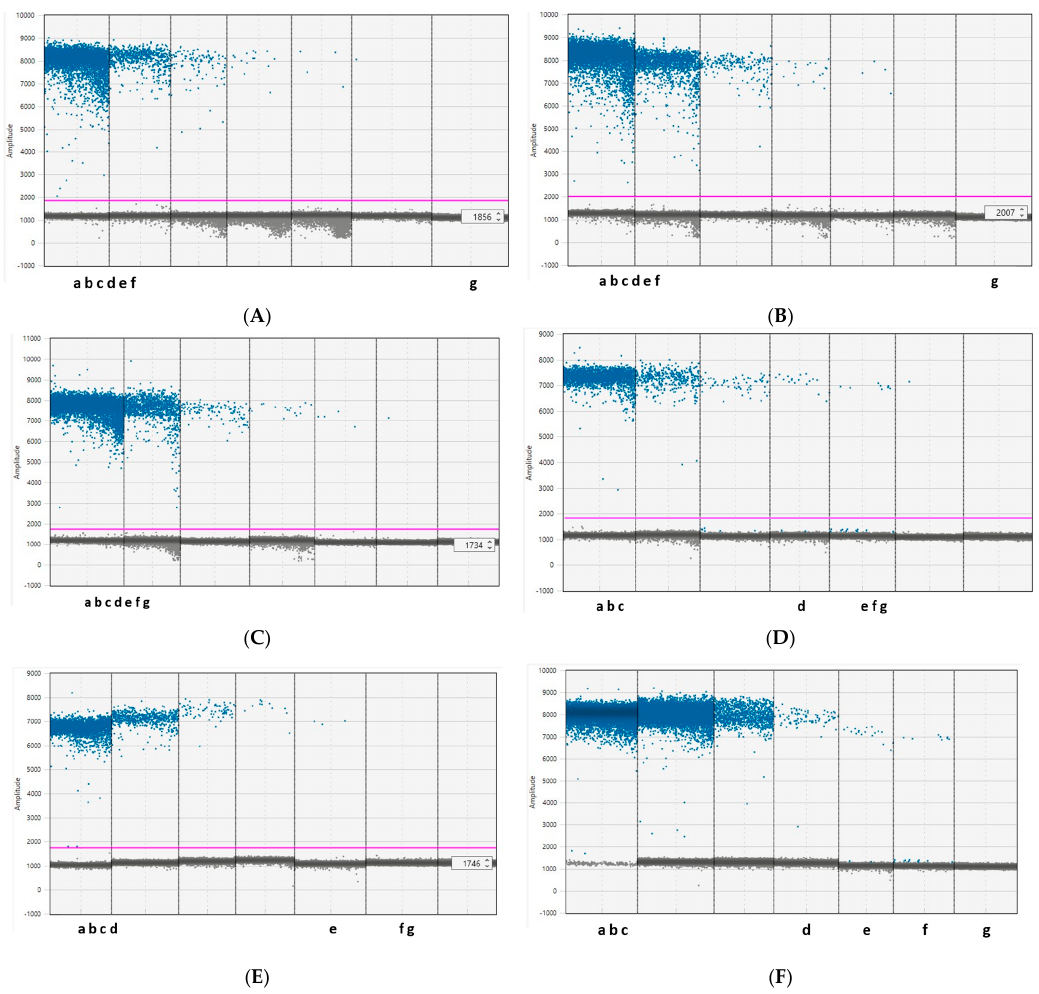
Figure 1. Comparison of the different limits of detection of Xf obtained by ddPCR in the five plant spiked matrices and in the insect vector at the optimized ddPCR parameters (600/300 nM primer/probe concentration and 45 end-point PCR cycles). Blue dots represent positive droplets above the pink horizontal threshold line. Gray dots represent the negative droplet background, with no amplification. ( A ): O. europaea ; ( B ): V. vinifera ; ( C ) : P. dulcis ; ( D ): N. oleander ; ( E ): C. sinensis ; and ( F ): P. spumarius . On x-axis : ten-fold dilution of Xf suspension reported in wells a to f; a : 10 6 CFU/mL; b : 10 5 CFU/mL; c : 10 4 CFU/mL; d : 10 3 CFU/mL; e : 10 2 CFU/mL; and f : 10 CFU/mL. Well g : NIC (negative internal control), specific for each matrix; on the y-axis : amplitude value. Table 4. Mean Cq values of the three replicates of 10-fold serial dilutions (CFU/mL) produced by qPCR Harper et al. (2010), modified for the spiked plant and insect